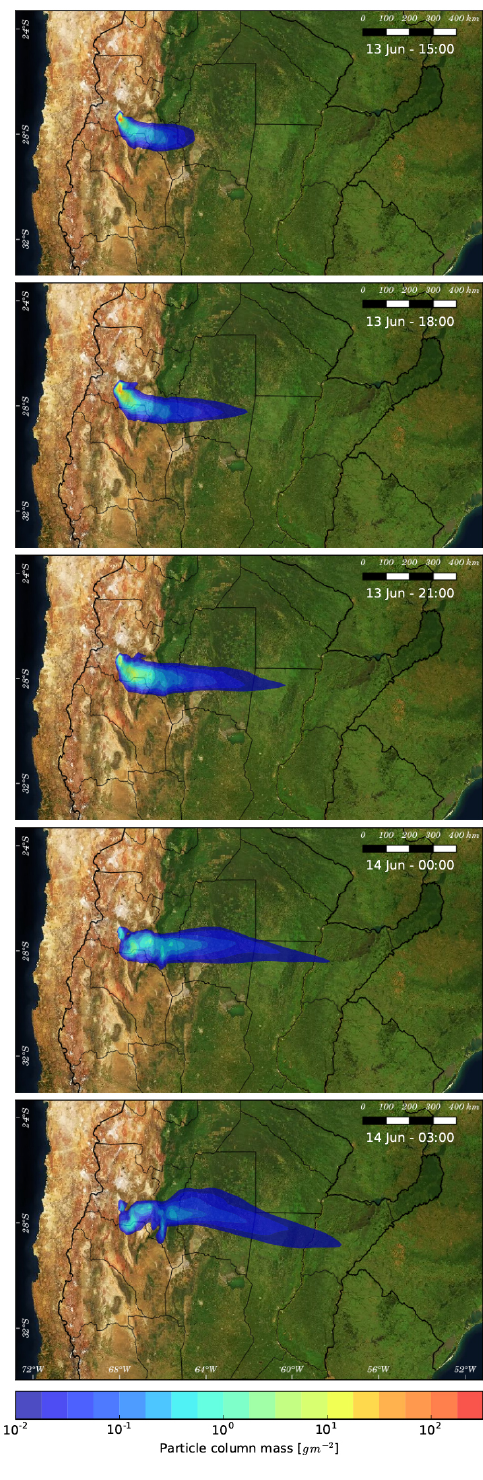
Figure 17. Column mass from FALL3D simulations using the al- ternative configuration. Vertical wind velocity was recalculated to reduce errors in sloping terrain. Simulation at 15:00, 18:00, 21:00 (13June), 00:00, and 03:00UTC (14